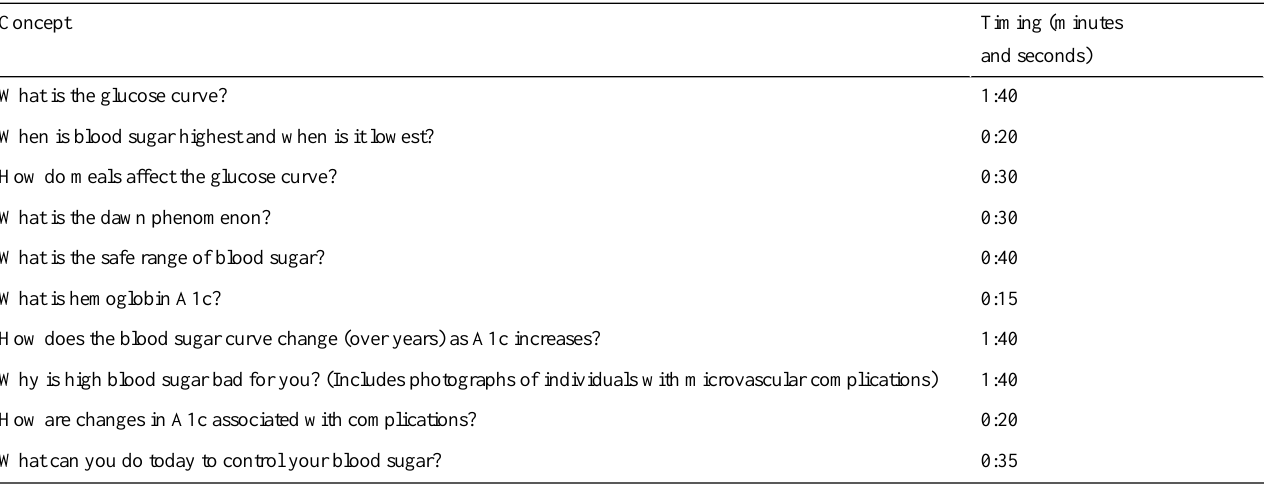
Table 1. Concepts included in the narrated simulation and their